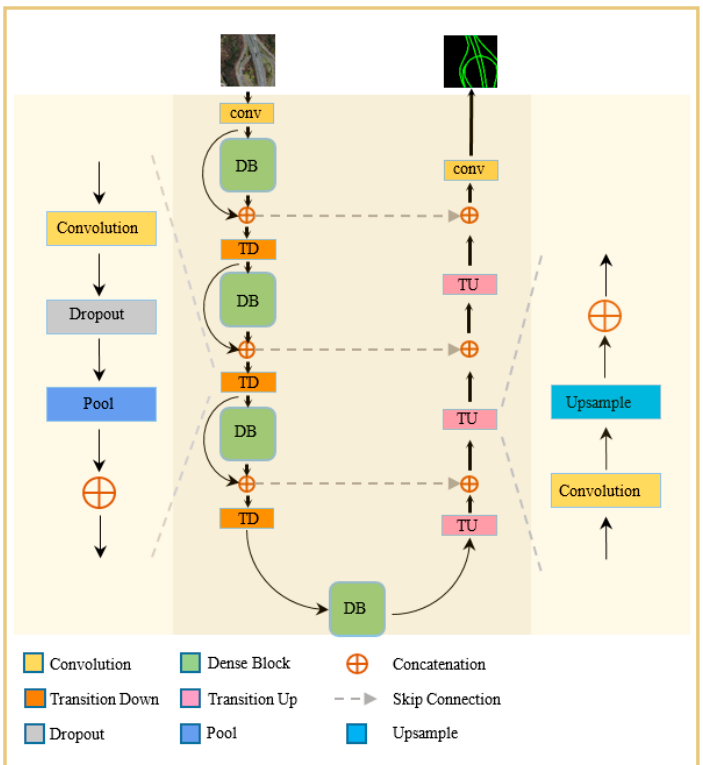
Figure 2. The architecture of the proposed deep DenseUNet. The dense block takes advantage of the potential of the network to efficient compression models through feature reuse.